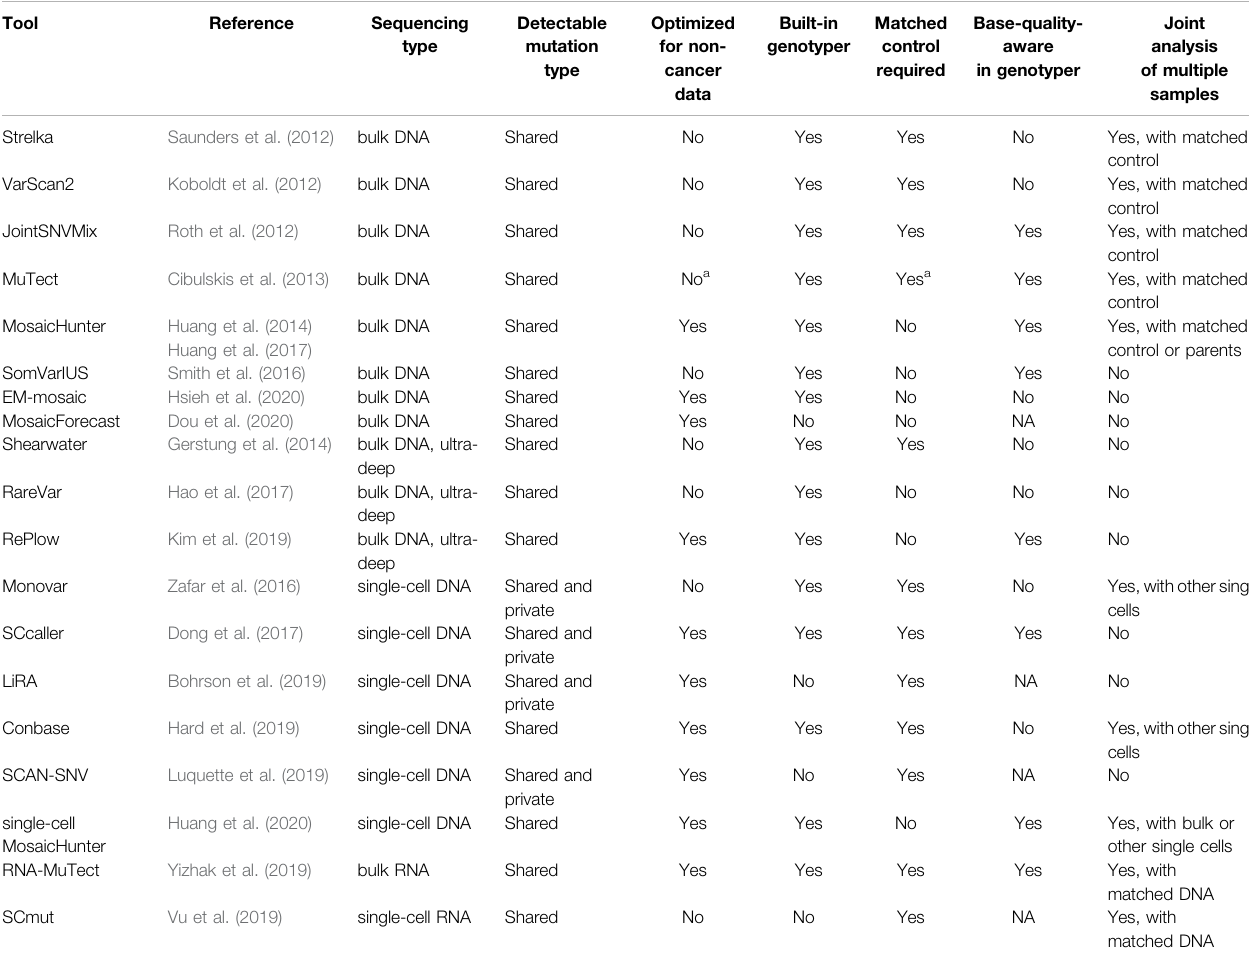
TABLE 1 | A selected list of tools for somatic mutation calling.